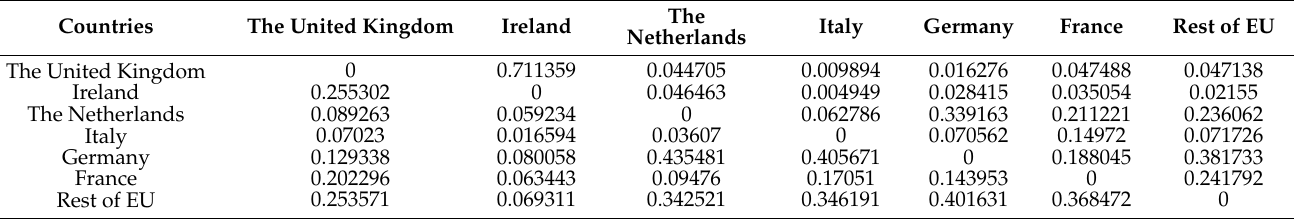
Table 1. Trade weights 1 based on total dairy product export